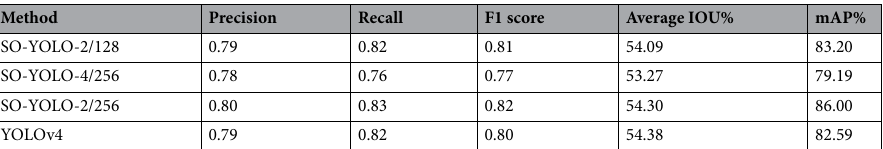
Table 1. Comparison of mAP and IOU on YOLOv4 and SO-YOLO. i.e., “2/128” means Resblock_body repeat 2 times and the dimension of feature map is 128.